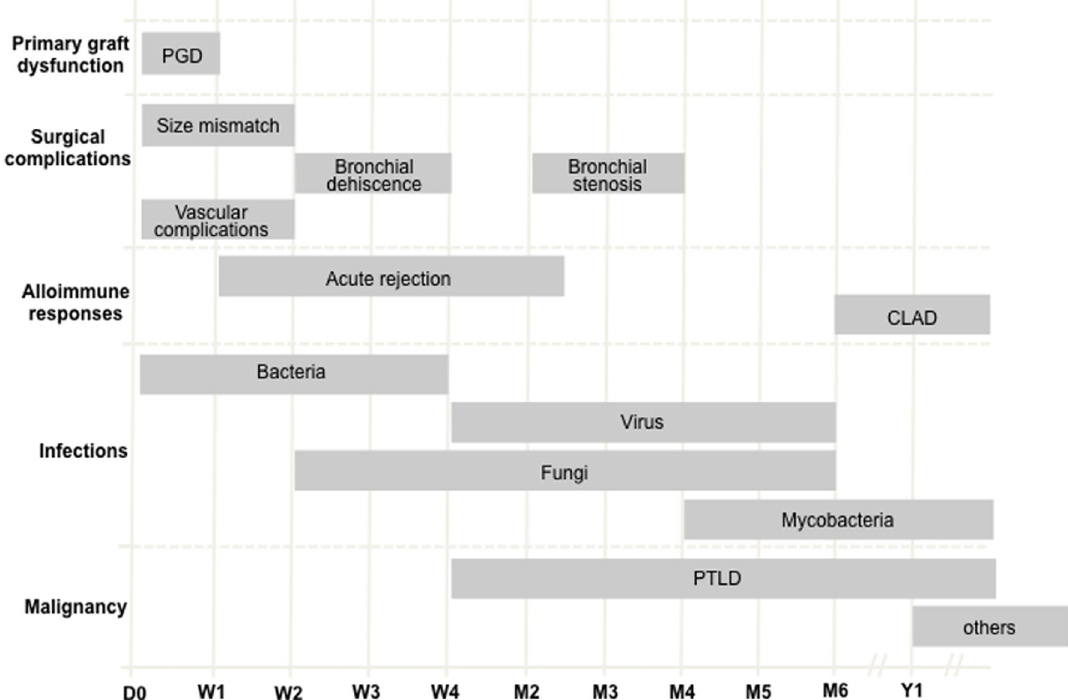
Fig. 1 Onset of complications following lung transplantation. Adapted from Ng et al. 2009 [4]. CLAD: chronic lung allograft dysfunction; PGD: primary graft dysfunction; PTLD: post-transplantation lymphoproliferative disease; D: day; W: week; M: month; Y: